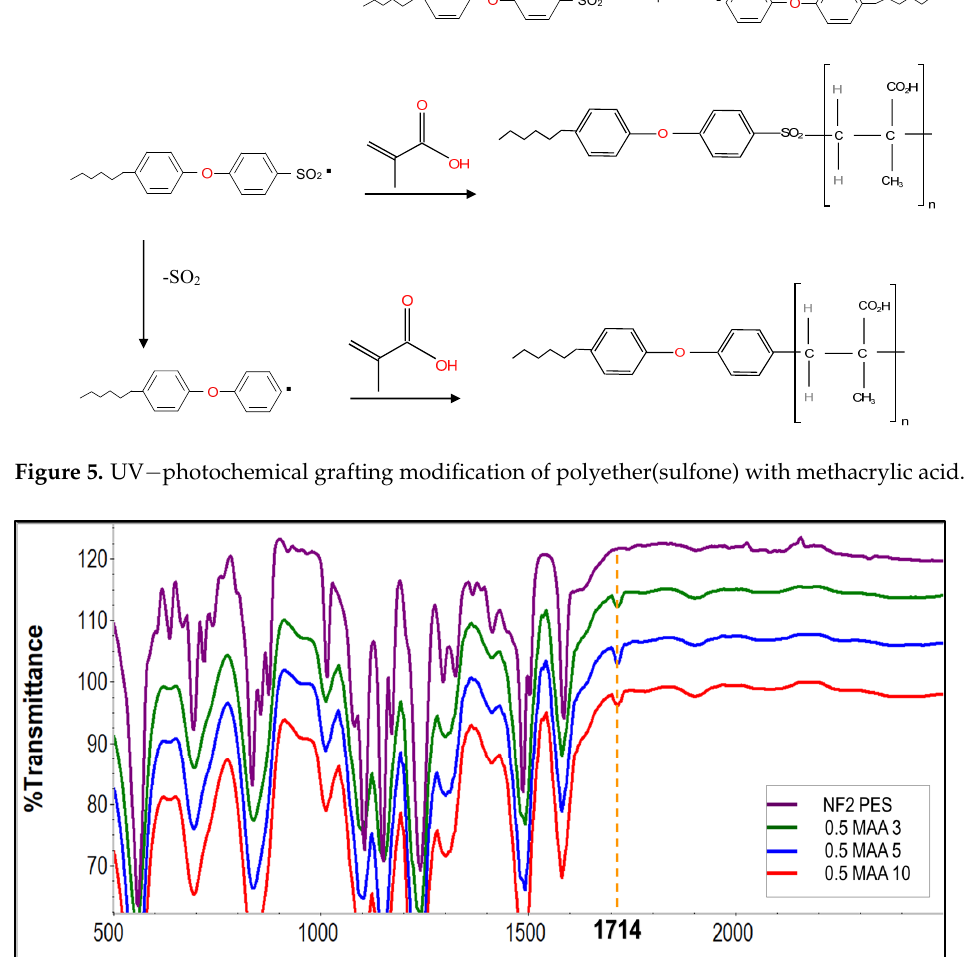
Figure 6. FTIR ‐ ATR spectra of the unmodified NF2 PES and UV − grafted membranes 0.5 MAA3, 0.5 MAA5 and 0.5 MAA10. 0.5 MAA5 and 0.5